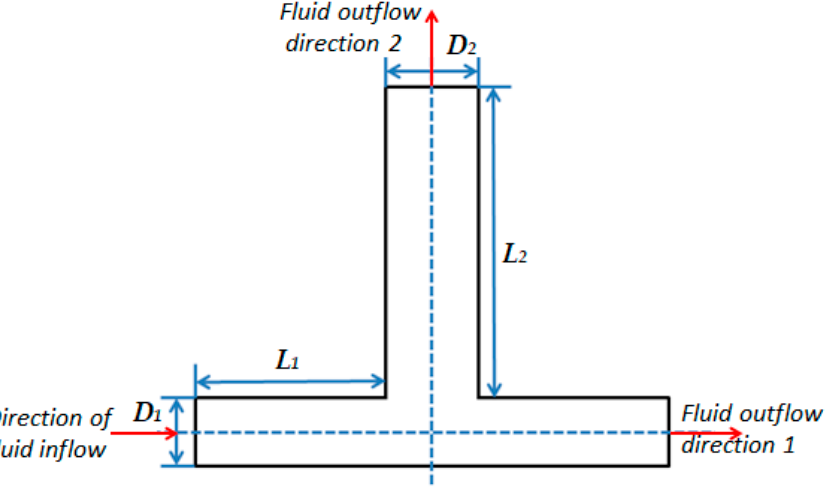
Figure 13. The model diagram of the tee.